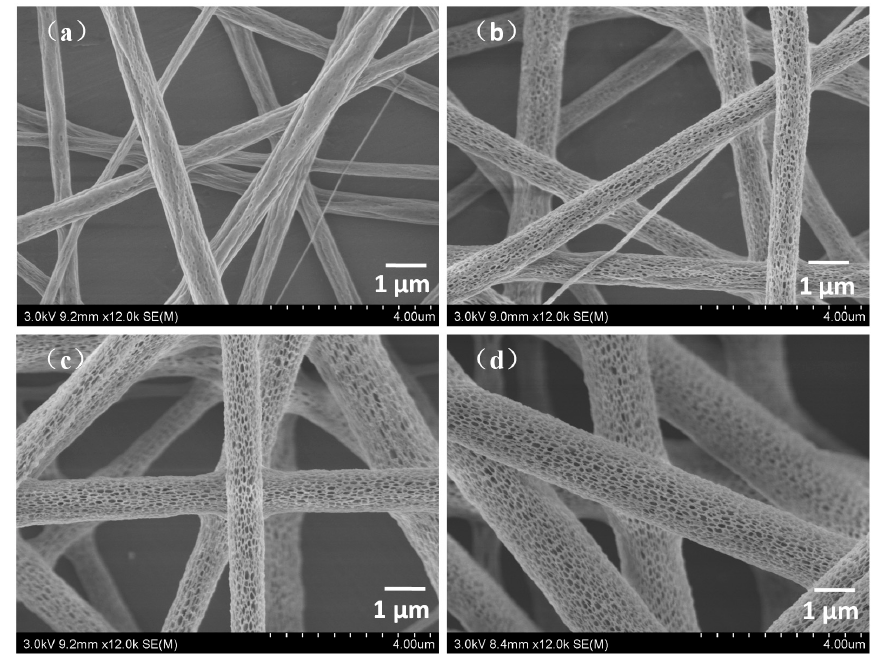
Figure 3. FE-SEM images of the PLA/chitosan fibrous membranes fabricated at different levels of humidity: ( a ) 15%, ( b ) 30%, ( c ) 45% and ( d ) 60%. Table 2. Characterisation of fibres prepared under various levels of humidity.